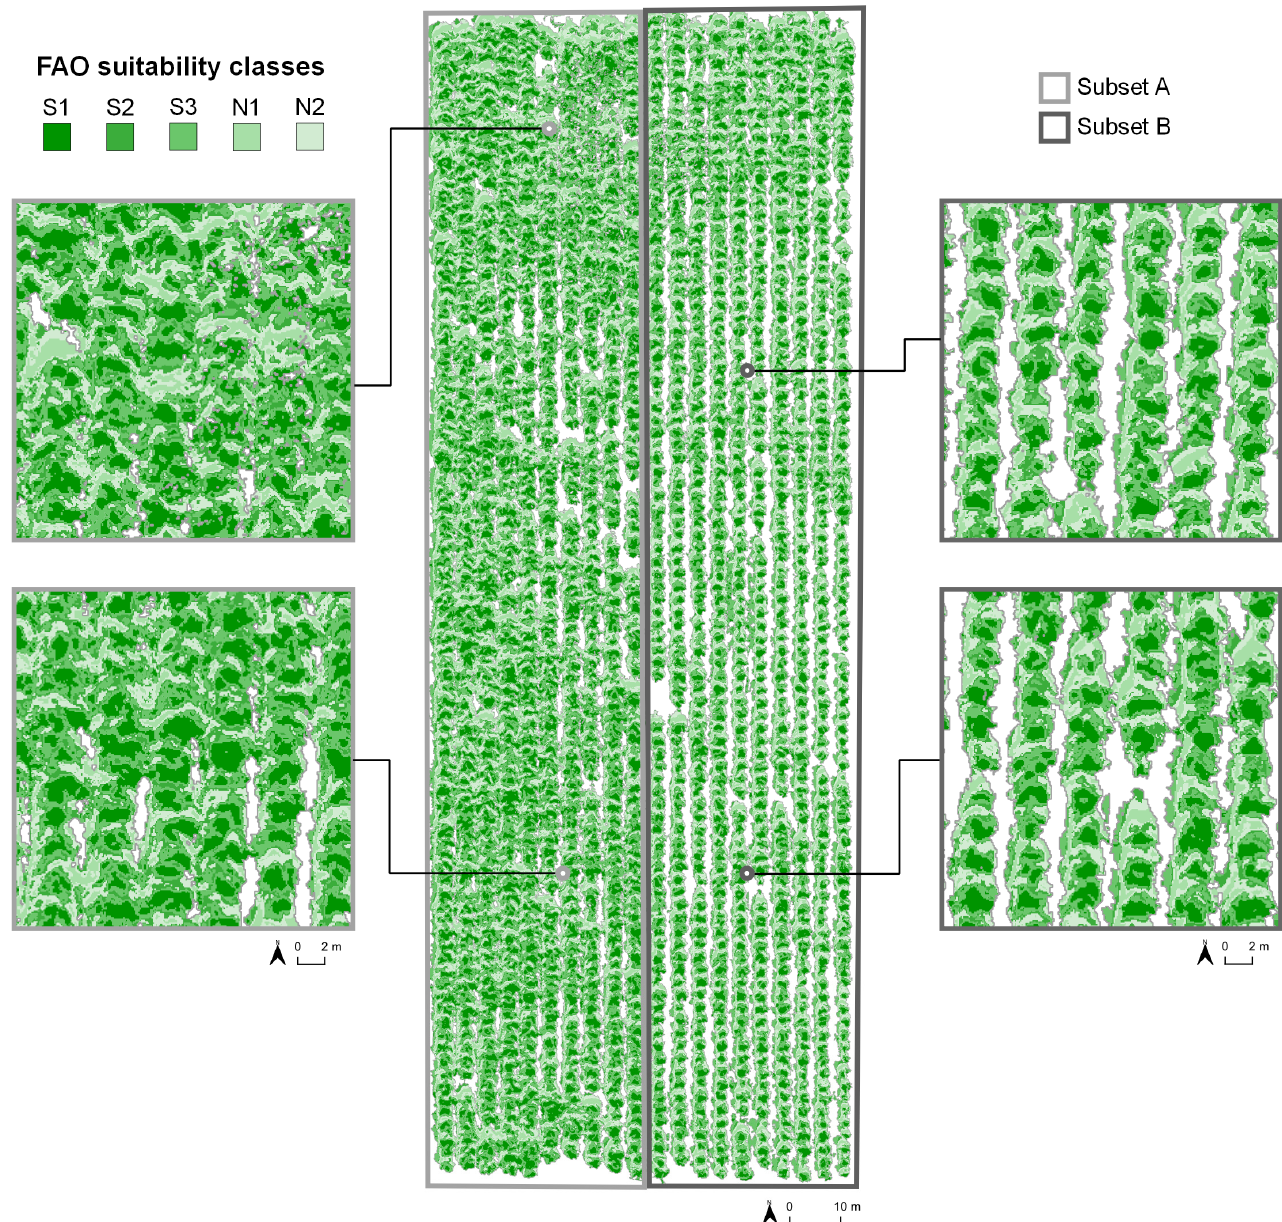
Figure 8. The final suitability map produced by the proposed cropland suitability assessment method at the micro-scale.